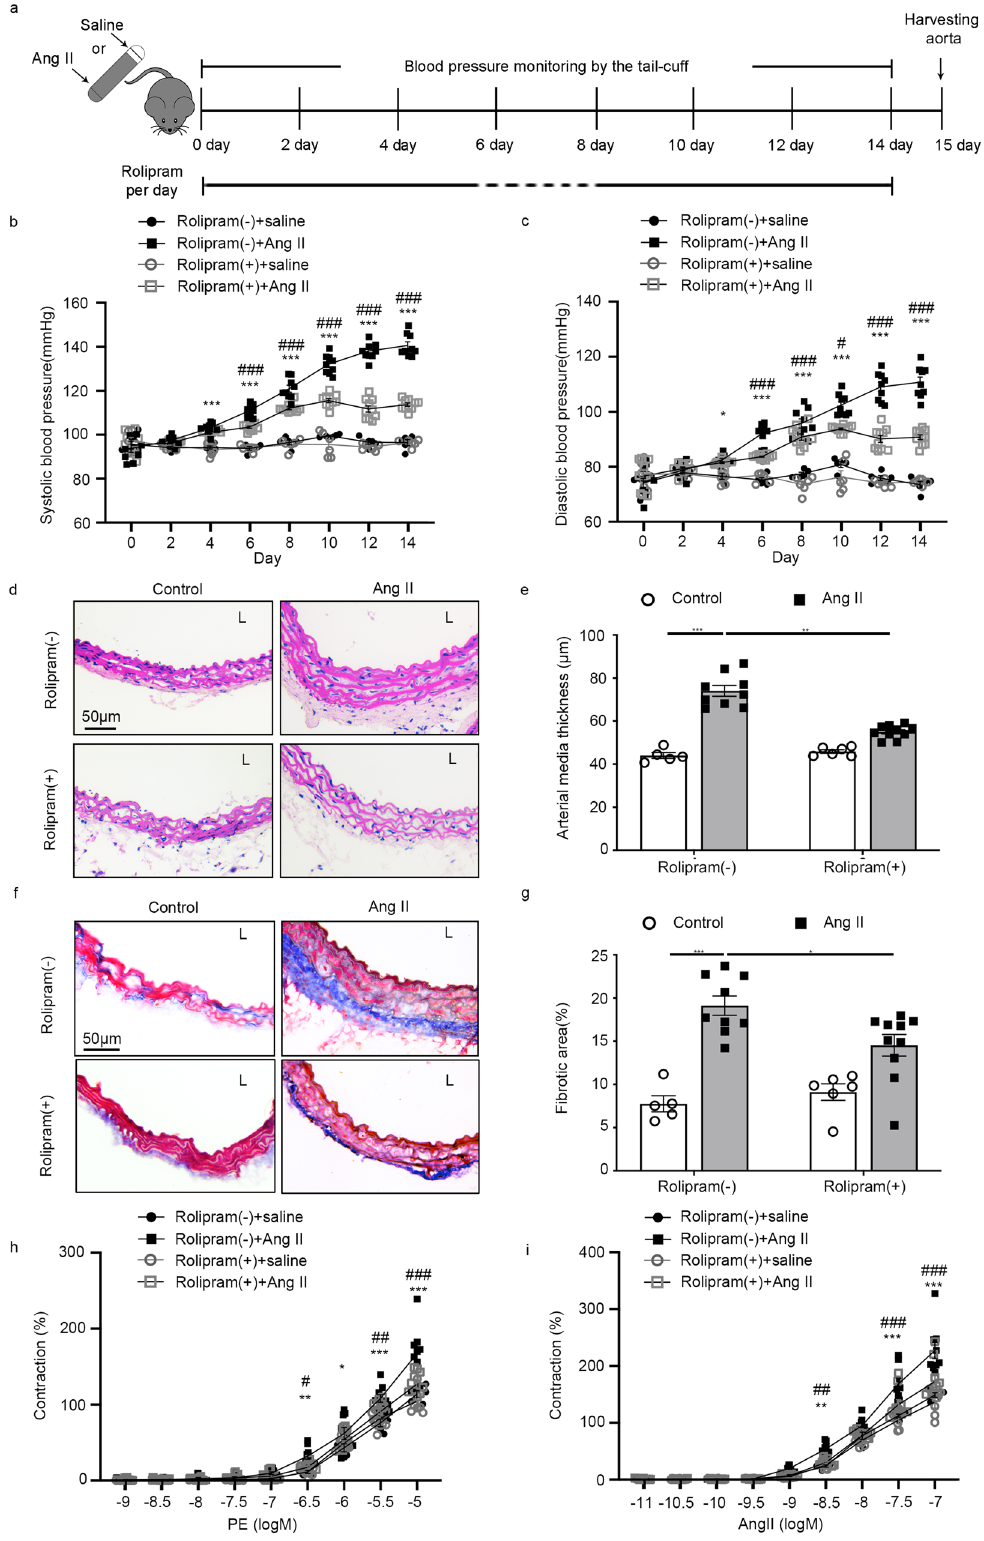
gavaged mice with rolipram (3 mg kg − 1 day − 1 ) or vehicle (Fig. 7a). Consistently with Figs. 2 and 6, SMC Pde4d de fi ciency or rolipram inhibited Ang II-induced increase of both SBP and DBP (Fig. 7b, c). However, there was no difference between Pde4d SMC − / − + Ang II + Rolipram ( − ) group and